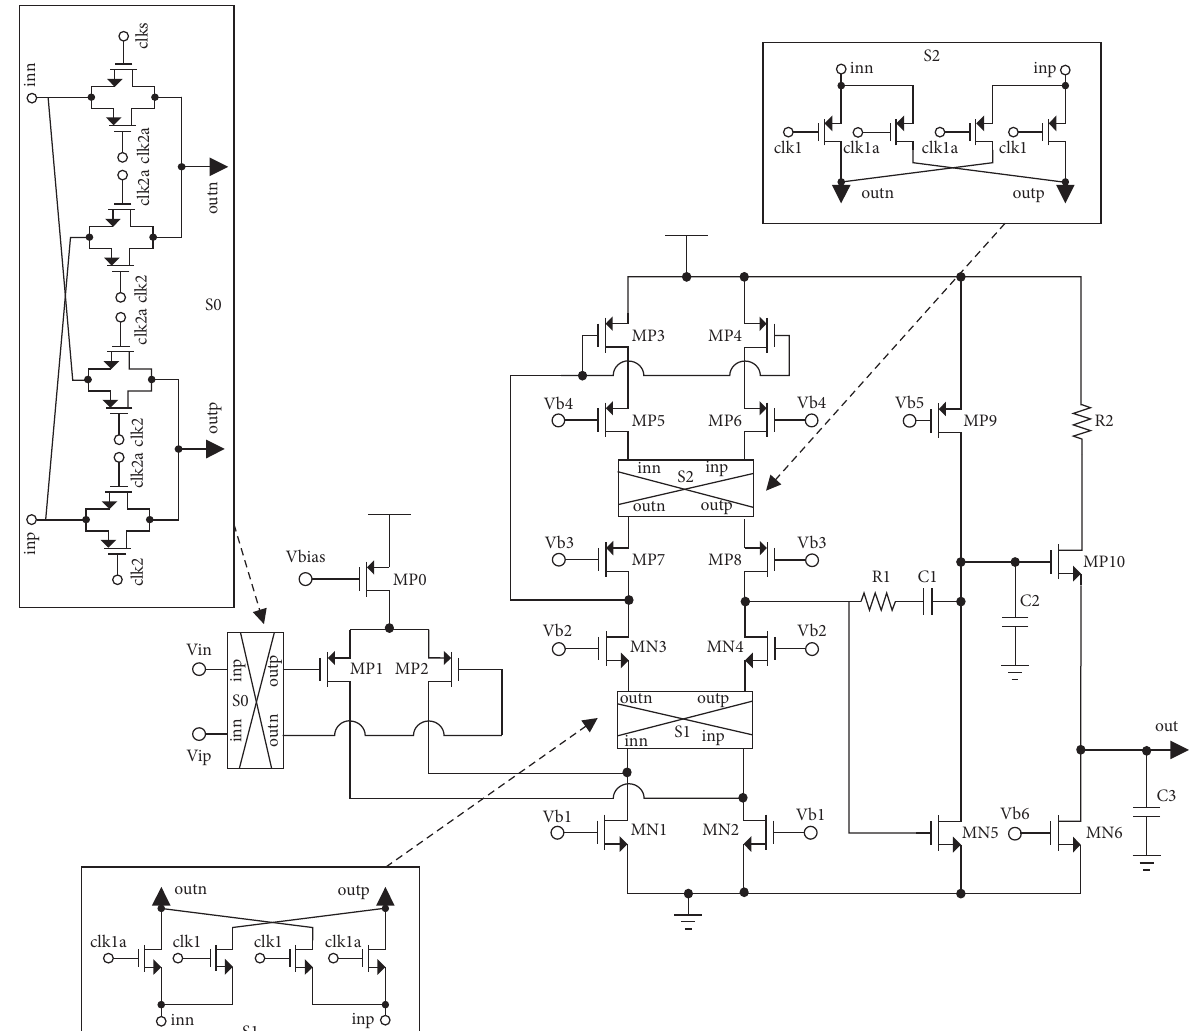
Figure 3: Two-stage chopper folded